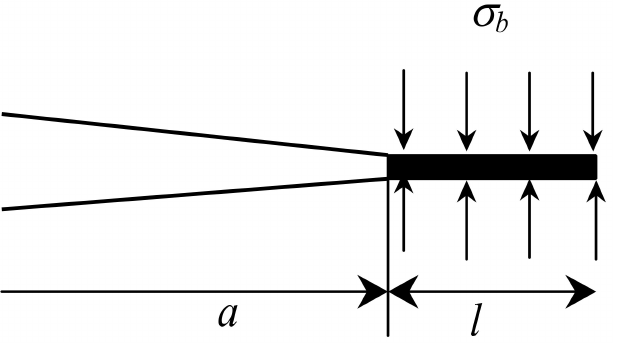
Figure 1. The strip yield